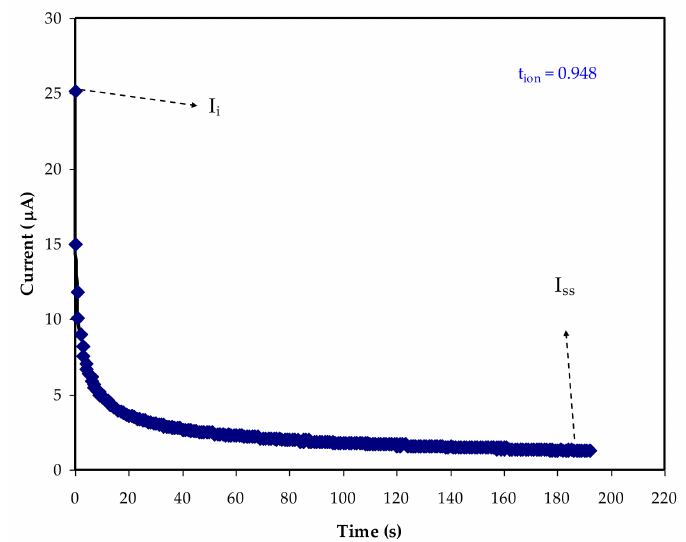
Figure 5. Polarization curve of current for the highest conducting